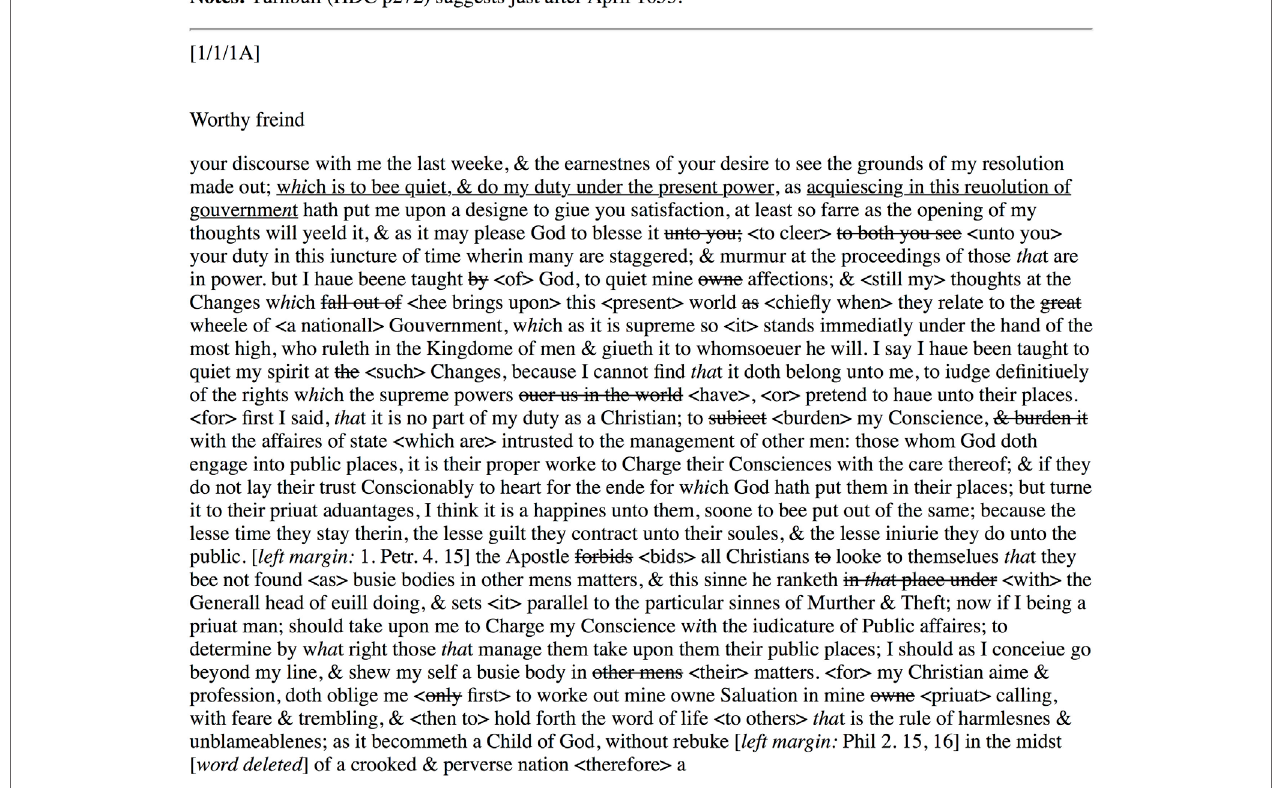
FigUre 2 | Rendered HTML sample taken from the Hartlib Papers. [Copyright: Greengrass et al. (2013). The Hartlib Papers. Published by HRI Online Publications, Sheffield. Available at: http://www.hrionline.ac.uk/hartlib.]